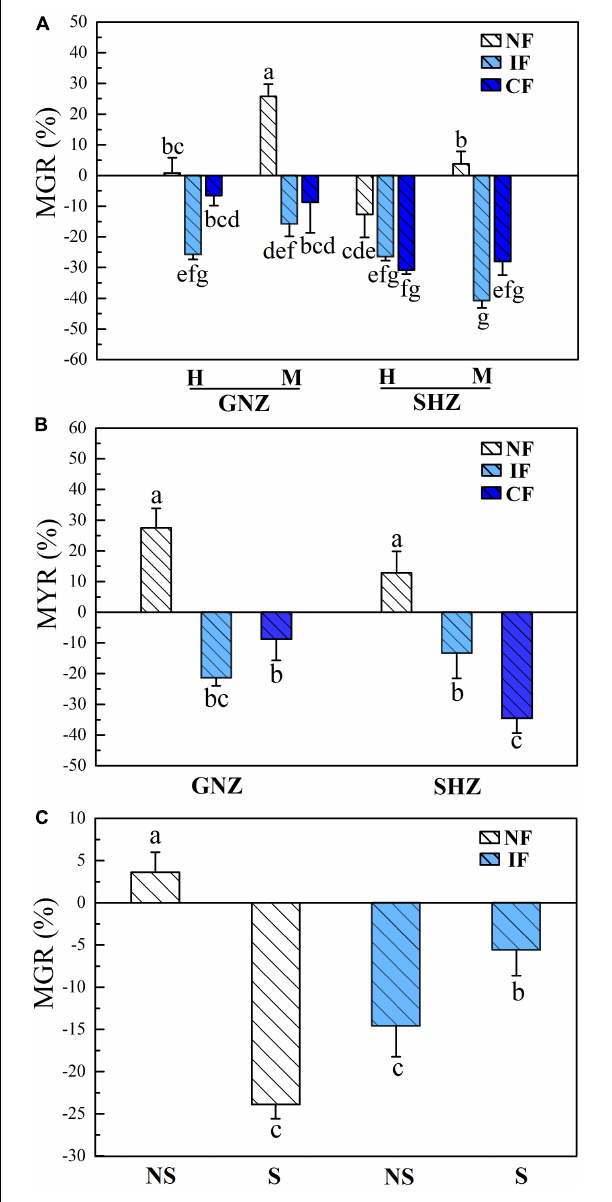
FIGURE 1 | Mycorrhizal growth response [MGR, (A) ] and mycorrhizal yield response [MYR, (B) ] in Exp. 1, as well as MGR (C) in Exp. 2. Rice varieties are indicated as GNZ, Guinongzhan; and SHZ, Sanhuangzhan. The rice varieties GNZ and SHZ were used in Exp. 1, and GNZ was used in Exp. 2. Rice growth stages are indicated as H, Heading; and M, Maturing. Rice plants were harvested at the heading and maturing stages in Exp. 1 and harvested at the heading stage in Exp. 2. Flooding treatments are indicated as NF, Non-flooding; IF, Intermittent flooding; and CF, Continuous flooding. Shading treatments are indicated as NS, Non-shading; and S, Shading. Different letters above the columns indicate significant differences at the P < 0.05 level. Means and standard errors from three (A) and five replicates (B) are